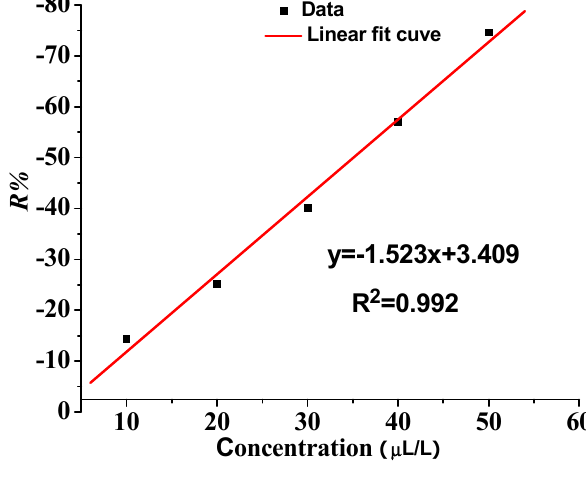
Figure 8. Linear relationship between the concentration of SO TiO nanotube array 2